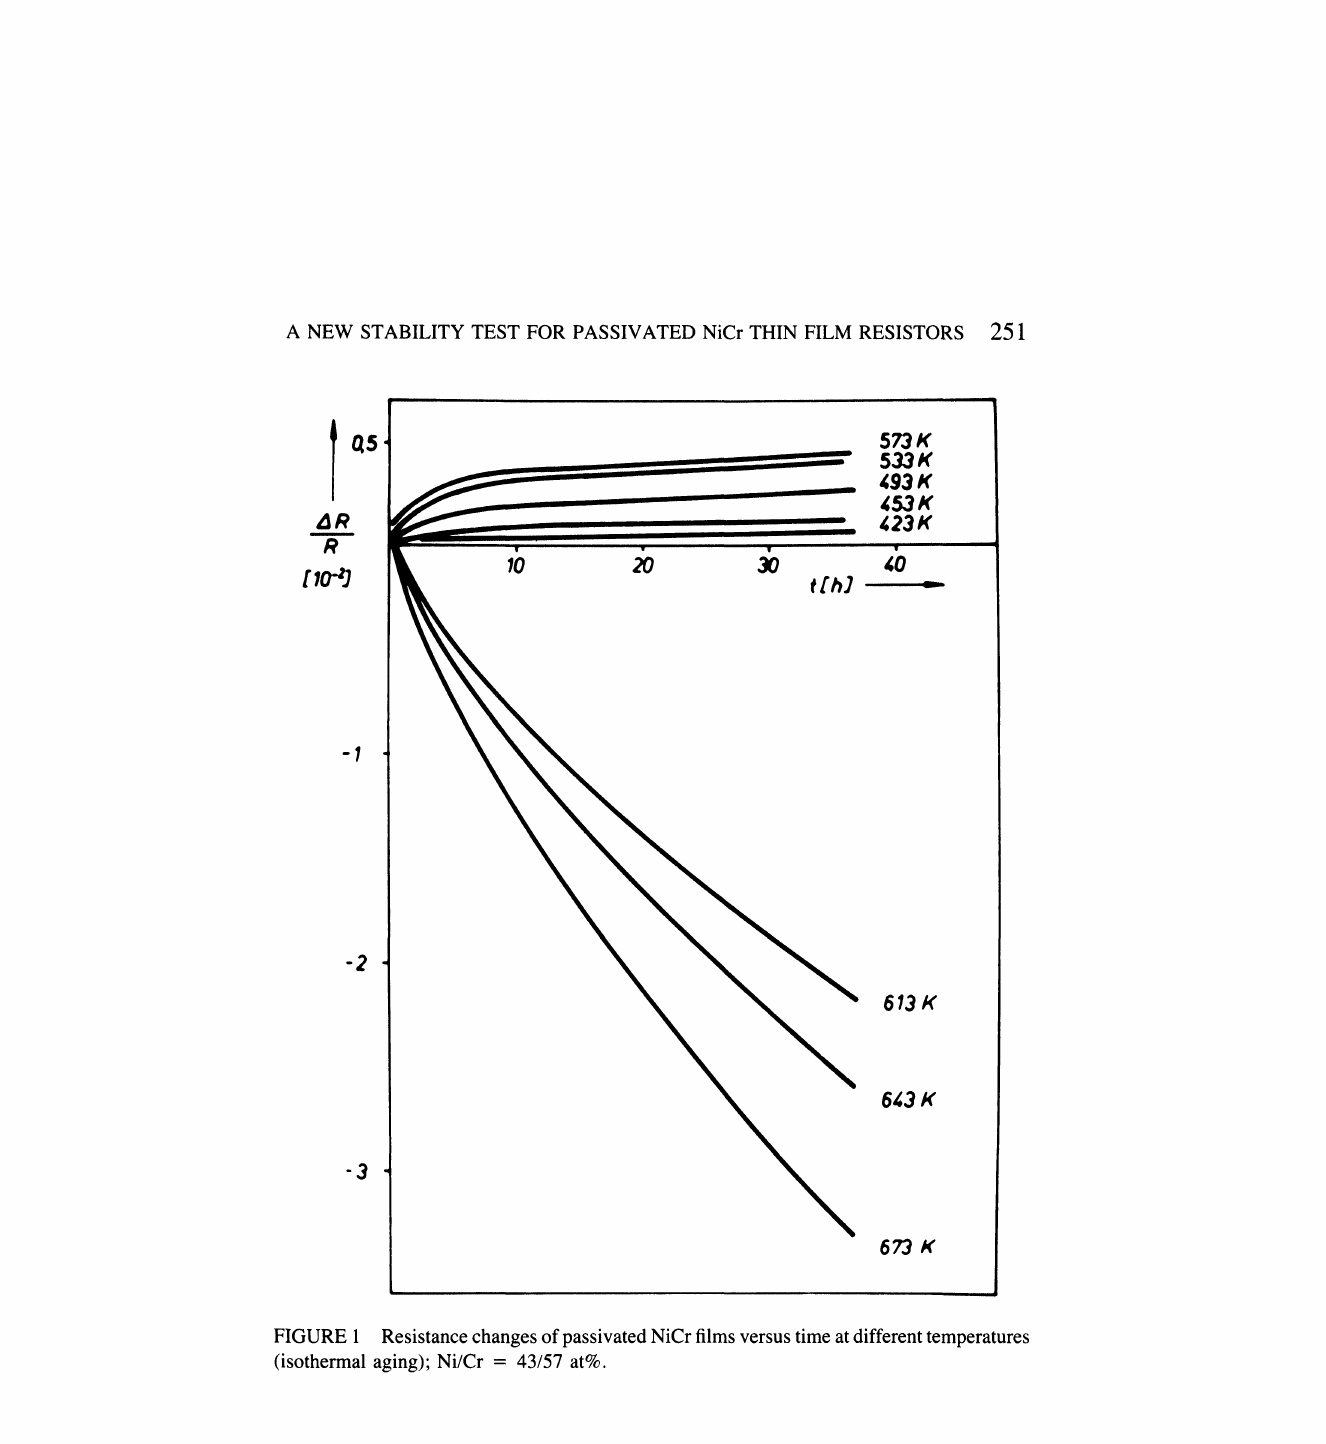
FIGURE Resistance changes of passivated NiCr films versus time at different temperatures (isothermal aging); Ni/Cr 43/57